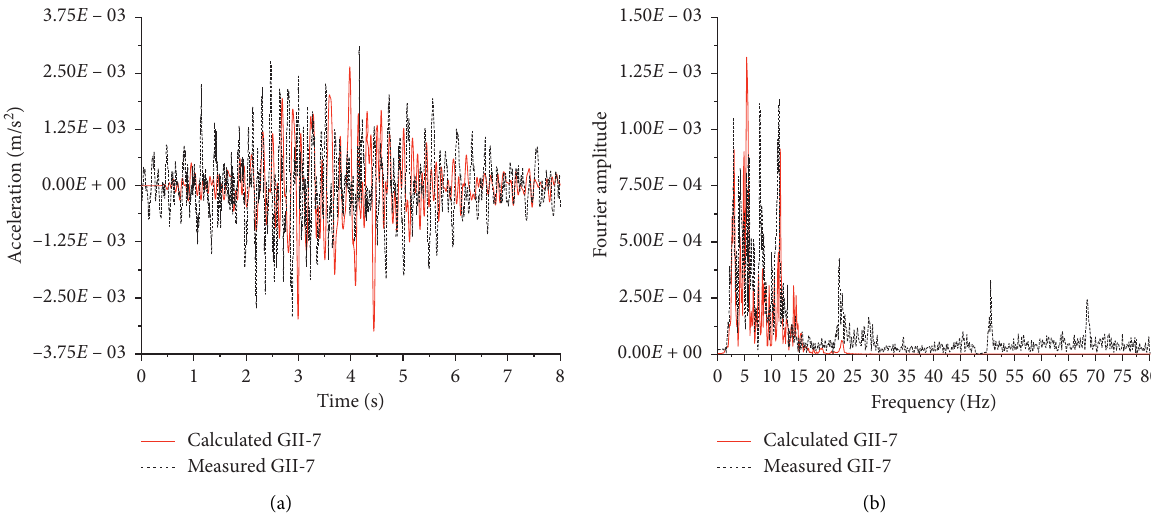
Figure 18: Comparison of numerical and field results (GII-7): (a) acceleration time history; (b) frequency